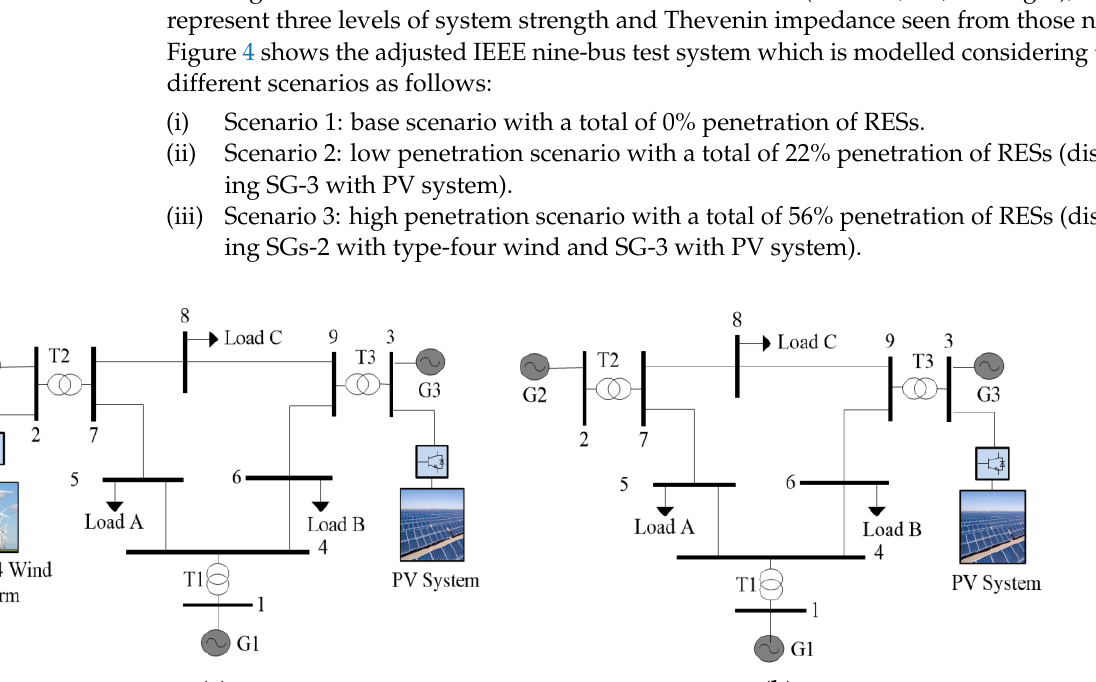
Table 1. Load distribution in IEEE nine-bus test system.